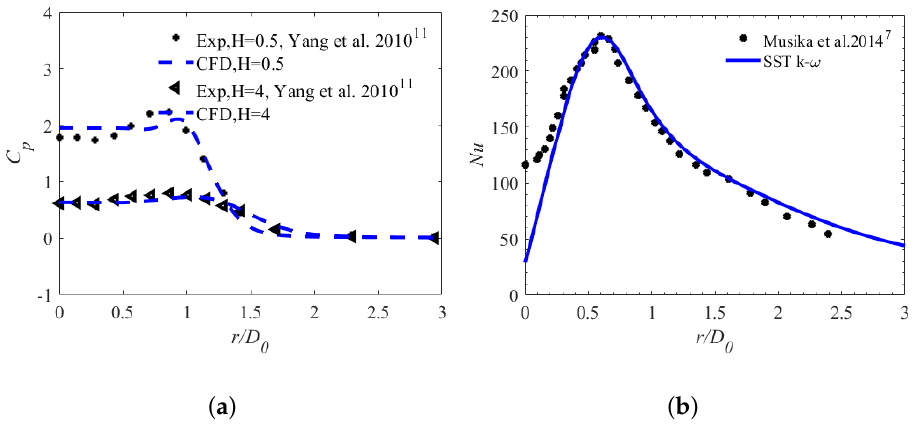
Figure 4. Validation of the CFD model using: ( a ) radial pressure coefficient distribution at H = 0.5 and H = 4. ( b ) radial Nusselt number distribution at H = 2.